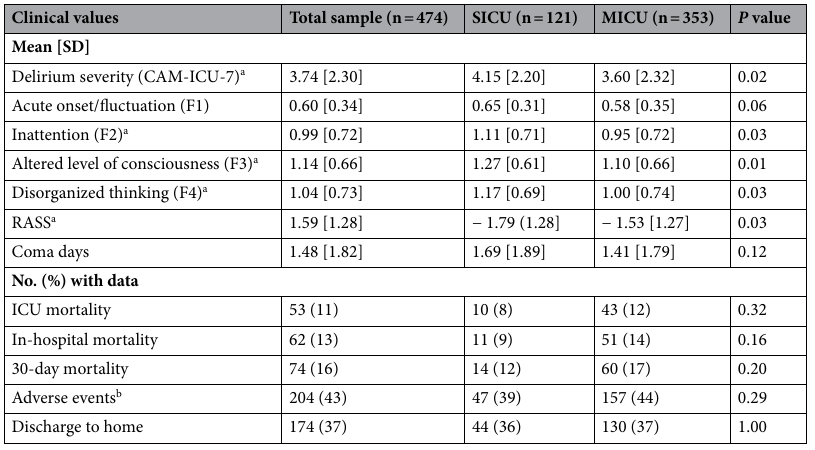
Table 3. Delirium severity, core features, mortality, adverse events, and discharge disposition (including coma). This table presents the delirium severity, core features, mortality, adverse events and discharge disposition compared between SICU and MICU setting, utilizing imputed coma scores as delirium severity of 7 days. CAM-ICU-7 confusion assessment method for intensive care unit-7, F feature, RASS Richmond agitation and sedation scale. a Statistically significant differences between MICU and SICU. b Delirium-related adverse events included falls, use of physical restraints, injuries such as pulling out IV lines or urinary catheters, re-intubations, and pressure ulcers.